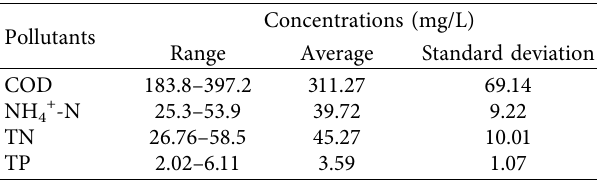
Figure 1: Sketch of the lab-scale A/O MBBRs. Table 1: Characteristics of domestic wastewater during continuous operation